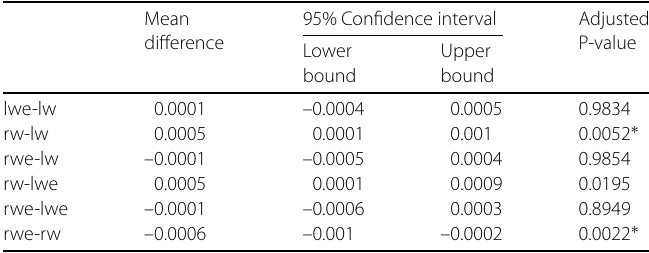
Table 18 ANOVA results to test for correlation of political orientation and extremity with text-based indicators of obedience to authority Degree of Sum of square Mean square F value Pr (> F ) freedom Political orientation 1 0.00000089 0.00000089 56.05 <0.001 ∗∗∗ Political extremity 1 0.00000004 0.00000004 2.38 0.123 Residuals 19,997 0.00027571 0.00000002 –